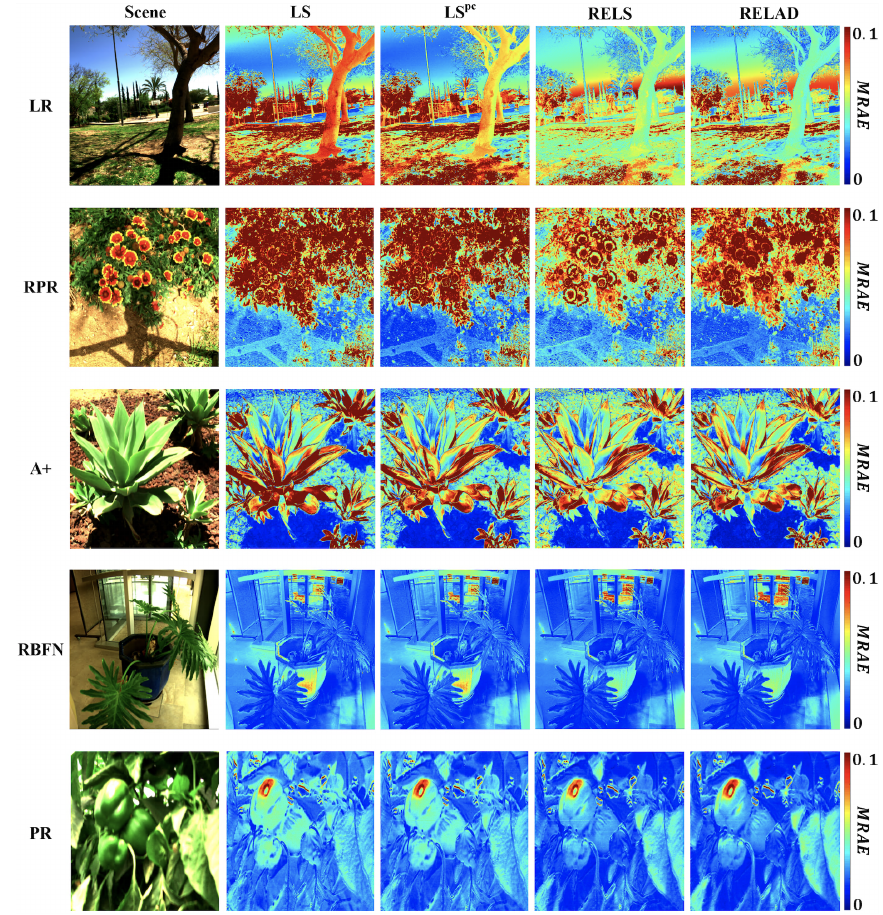
Figure 4. The MRAE error heat maps for the considered regression models optimized for LS, LS pc , RELS, and RELAD